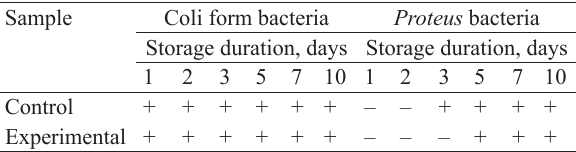
Table 6 Change in fish mass during storage Duration of storage, days